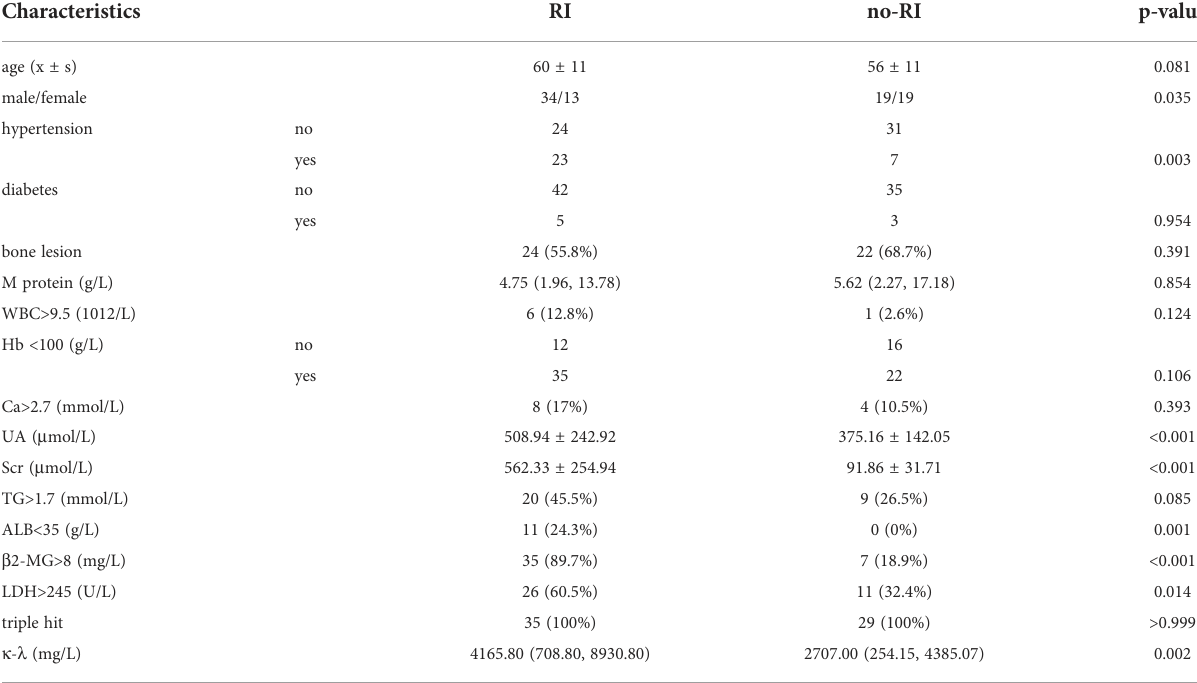
TABLE 1 Baseline characteristics of RI and no-RI patients.